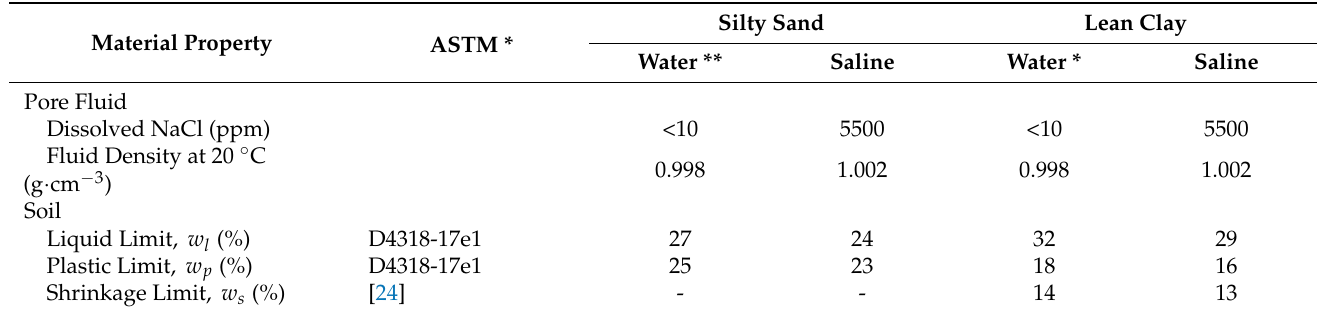
Table 1. Summary of material properties.